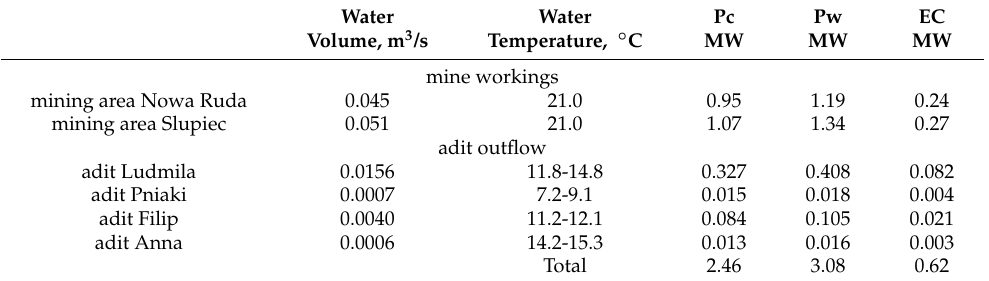
Table 6. Geothermal potential and energy balance for mining waters in the Nowa Ruda